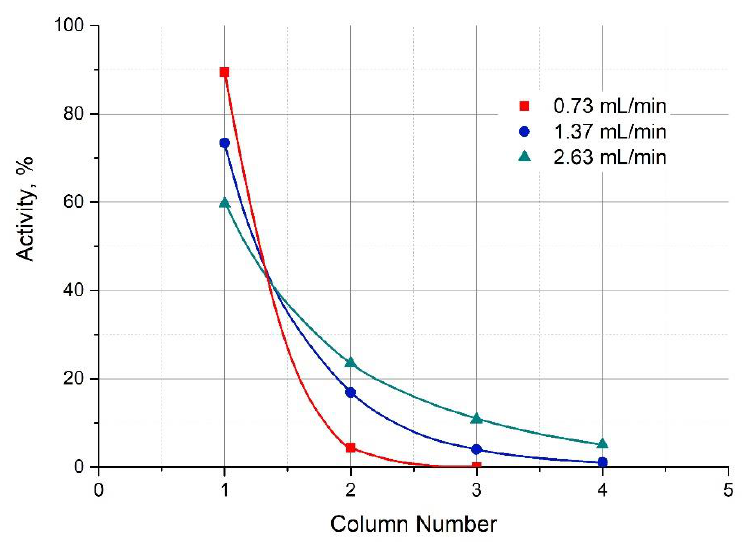
Figure 5. Distribution of 213 Bi activity on the series-connected columns with 0.10 mL of AG MP-50, each depending on the flow rate of 0.25 М HNO 3 eluent solution.